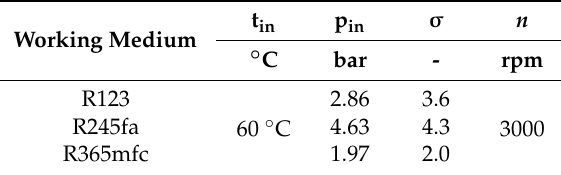
Table 2. Boundary conditions and model